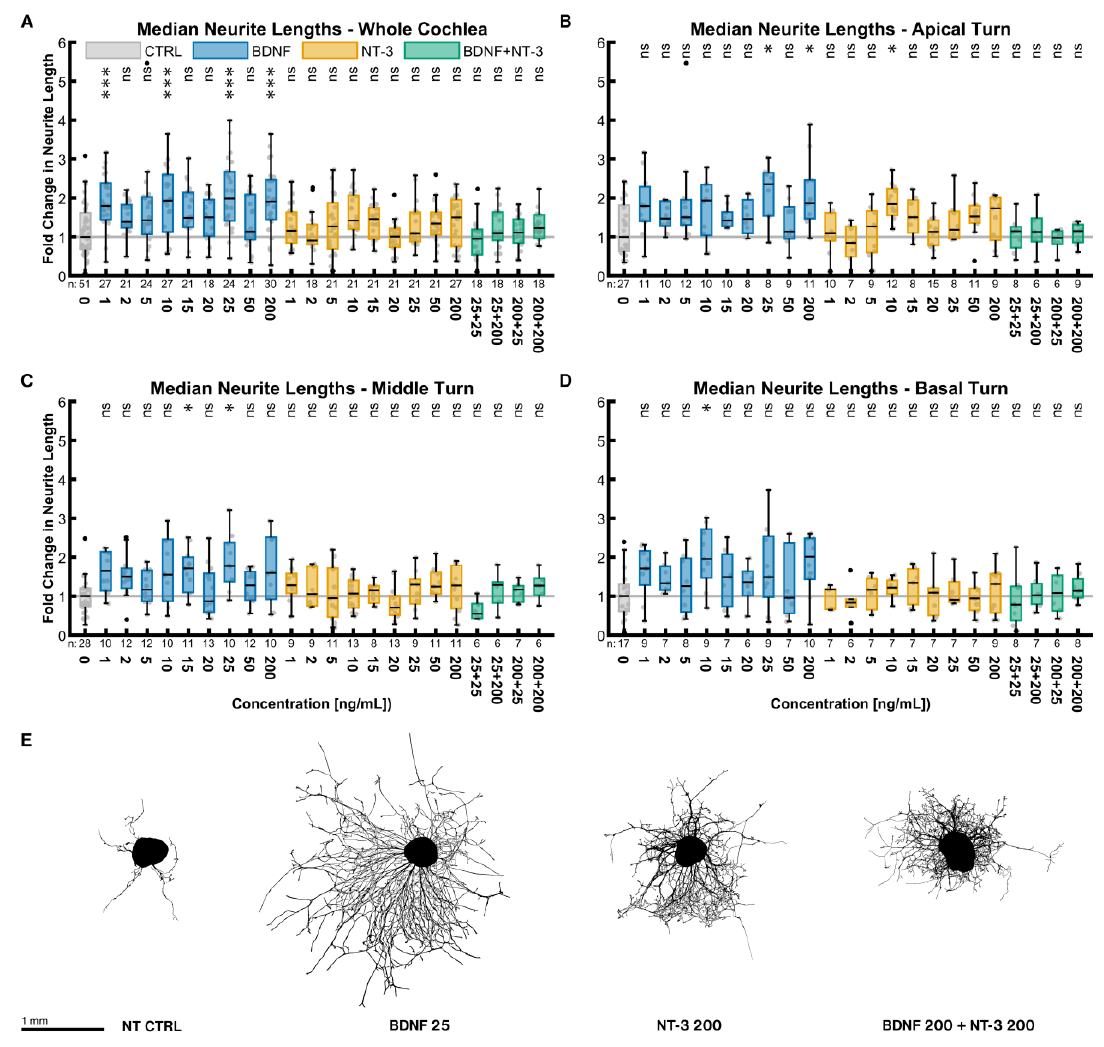
Figure 2. Median neurite lengths with neurotrophic supplementation. The diagrams ( A – D ) show the fold change of the median neurite length of every explant regarding the median of the control group with different neurotrophic supplementations. The groups in the first graph ( A ) contain an equal number of samples from three turns, hence representing the whole cochlea. Diagrams ( B – D ) depict the individual turns. ( A – D ) The boxes extend from the 25% to the 75% percentile. The black bar denotes the median. The whiskers delimit the 1.5-fold interquartile range. Samples within this range are marked as grey dots, and samples beyond this range are black. A grey line marks the median of the control group. The number of samples in each group is written right below the X-axis. The asterisks or ns (not significant) above the groups indicate the significance level of a Kruskal–Wallis test followed by a Dunn’s multi-comparison post-hoc test against the control group. ( E ) Representative explants at the median of the best-performing groups in ( A